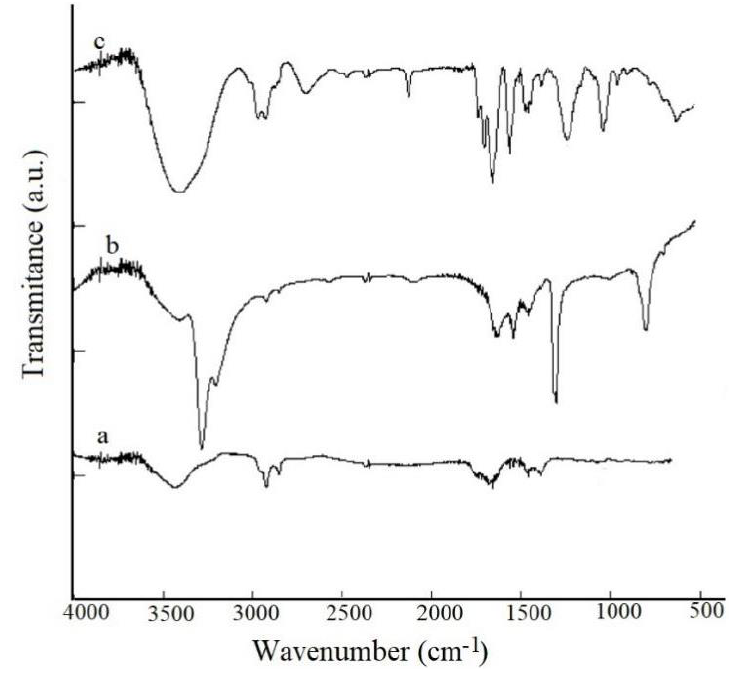
Figure 1. FTIR spectra for ( a ) MWCNT-COOH; ( b ) CDDP; ( c ) MWCNT-COOH-CDDP.